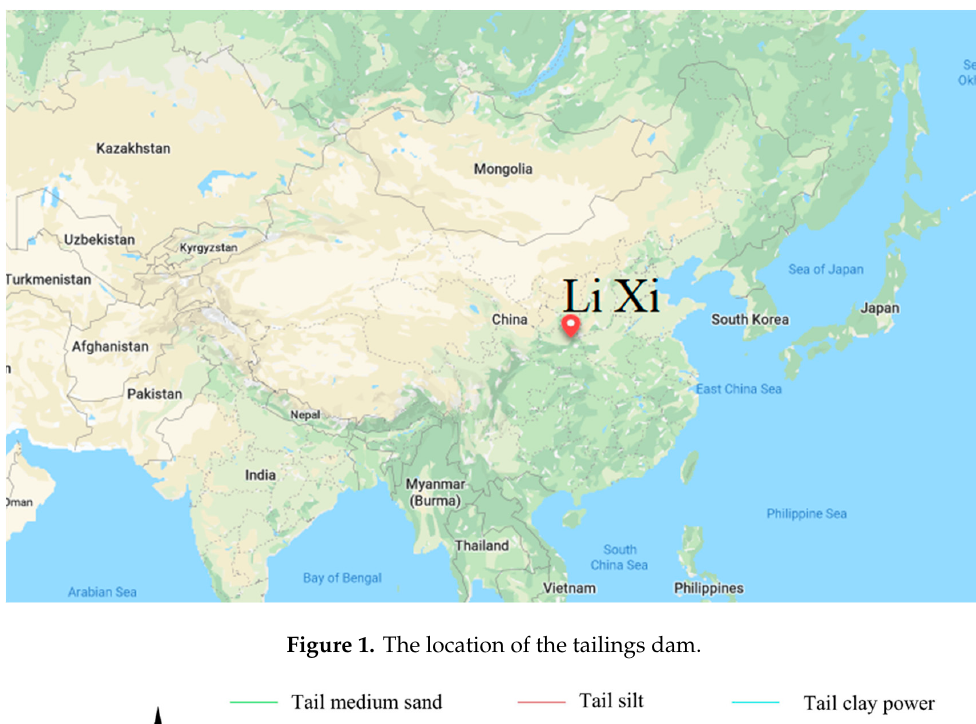
Figure 1. The location of the tailings dam.